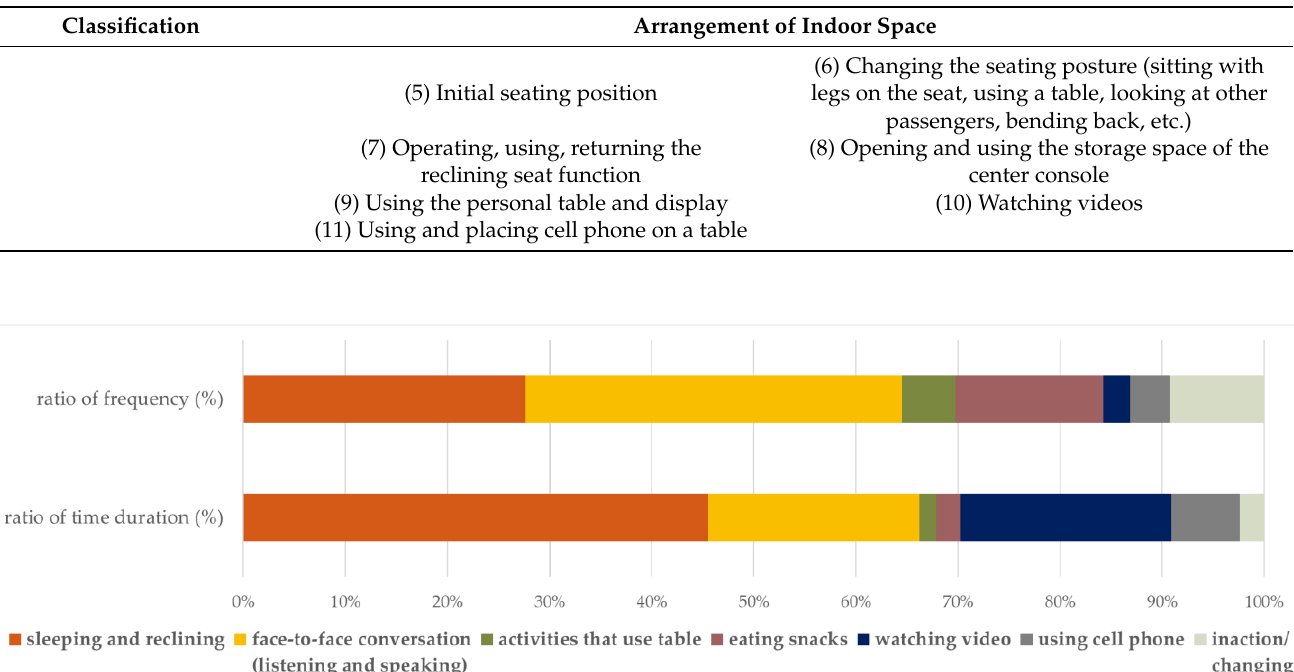
Figure 3. Ratio of frequency and time duration. Table 7. Analysis of “action” unit characteristics by “activity” unit ( (1) ratio of frequency (%), (2) ratio of time duration (%), (3) the number of activities that took place concurrently, (4) in the case of table-use activity, the task of completing the questionnaire is performed, and thus, it is excluded from the analysis of the ratio of frequency and ratio of duration).